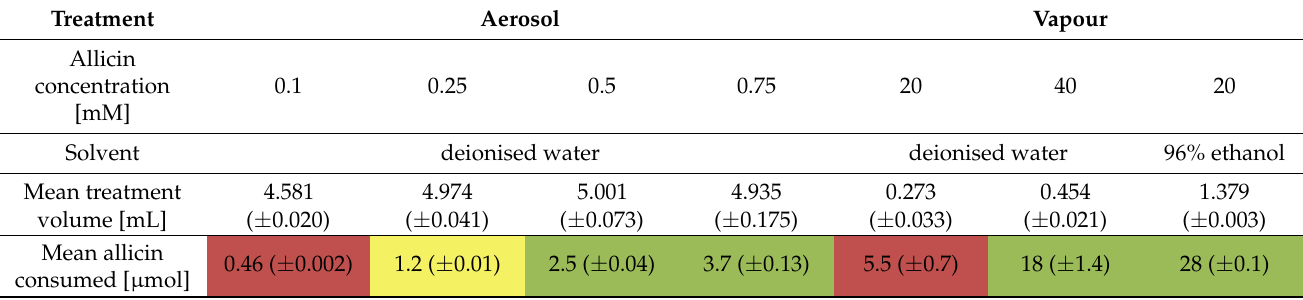
Figure 5. Ethanol as a solvent promotes the antimycotic activity of allicin via the gas phase. For gas phase experiments, synthetic allicin was diluted in either deionised water (diH 2 O) or 96% ethanol. The lung model was coated the same as for the aerosol treatment (20 mL 2% ( w / v ) PDA with 10 6 spores per mL of Paecilomyces formosus per half). The supply air was adjusted to 6 L per min, treatment duration was 20 min. The model was subsequently incubated at 37 °C. ( A ) After 24 h and 48 h of incubation, fungal growth was detected by staining with MTT. The lower half of the experiment model is shown. ( B ) Binary images of the 48 h incubated model halves. ( C ) n = 3, error bars show standard deviation. Significant differences between the treatments in a Student’s t-test are marked by asterisks ( p < 0.001 = ***; n = non-significant). Lastly, the amounts of allicin consumed in the treatments described above were cal- Table 1. Calculation of allicin consumption in the treatments. n = 3, antifungal activity is displayed culated (Table 1). Therefore, allicin concentration used was multiplied by the solution vol- and is color-coded: red = weak, yellow = medium, green = ume consumed. To observe antifungal activity, higher initial concentrations were needed